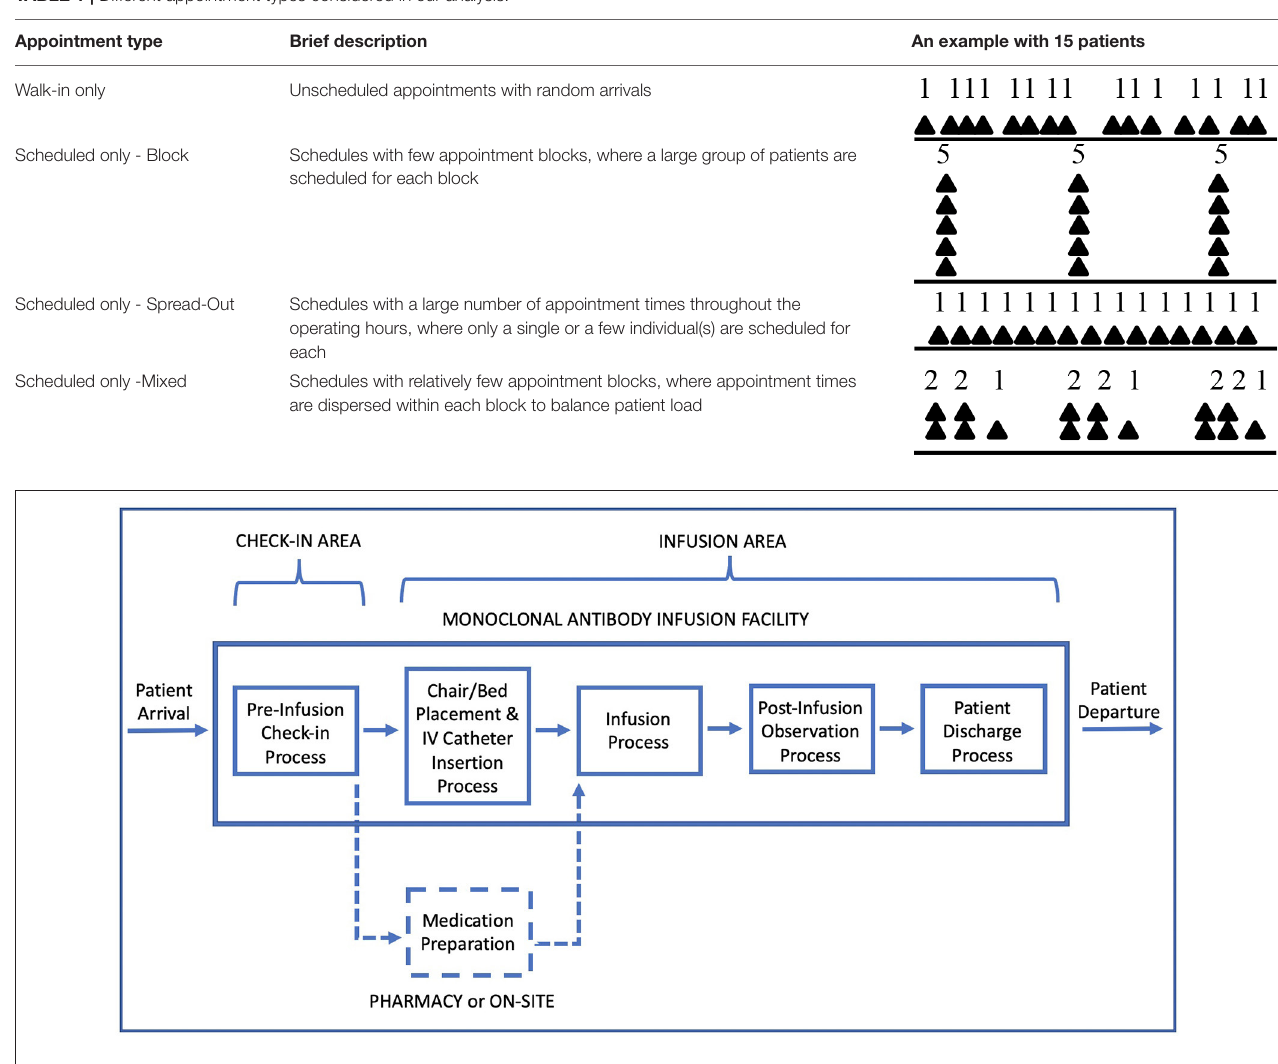
FIGURE 1 | Patient flow diagram in a monoclonal antibody infusion